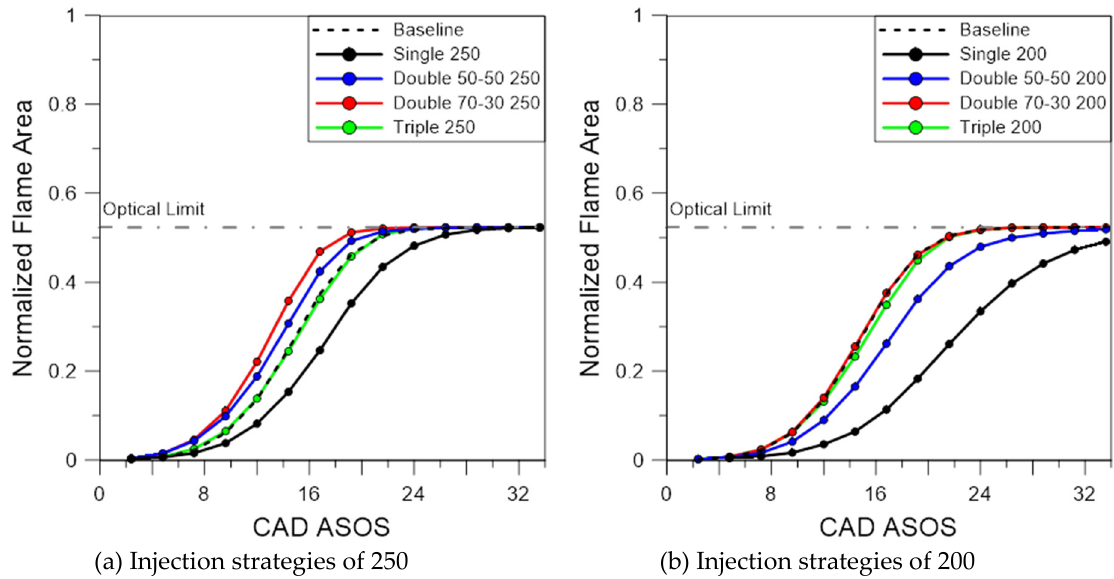
Figure 10. Flame area growth versus crank angle degree for injection strategies of: 250 ( a ) and 200 ( b ). Flame speed values were calculated for each case from the area growth graph. The main hypothesis is to consider the flame perfectly spherical until the wall is intercepted. The maximum value for each injection strategy is shown in Figure 11. The trend reveals a decrease of flame propagation speed when delaying the start of injection (by 50 CAD). The largest differences were found for single and double 50-50, due to the increase of injected fuel during the last phase of the intake stroke. For these operative conditions, the peak values of flame speed were found to be between 20 and 25